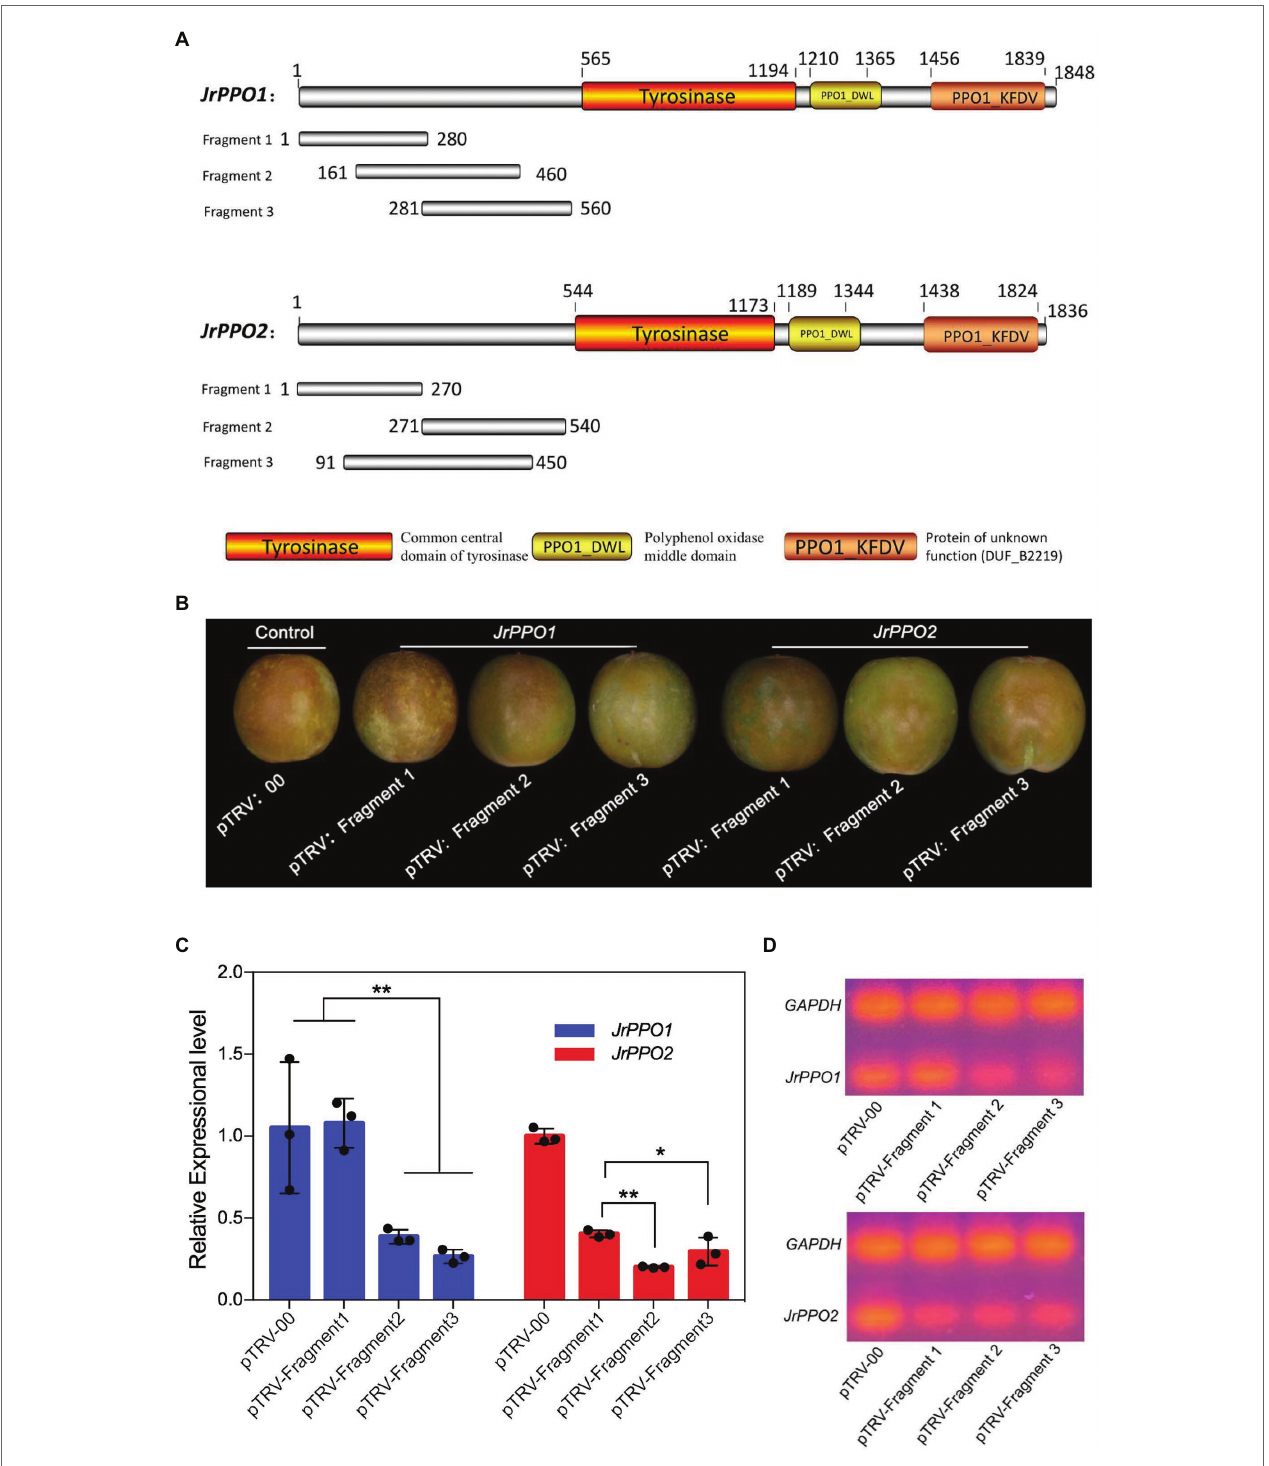
FIGURE 5 | Schematic representation of JrPPOs fragments designing and screening. (A) JrPPOs silencing fragments design. The three fragments located in the non-conserved domain of JrPPOs were selected to prevent silencing interference. Colored boxes indicate the three conservative domains. (B) Pictorial representation of fruits treated with constructs harboring different fragments at 8 dpi. These fruits were photographed 1 h after the fruits were removed from the inoculation solution. The obvious difference in the phenotype of different experiments did not show until 1 h later. (C) Quantitative RT-PCR showing the decreased JrPPOs levels. The screening for the most efficient fragment was successful. Data were pooled across experiments, and Student’s t -test was used for analysis.